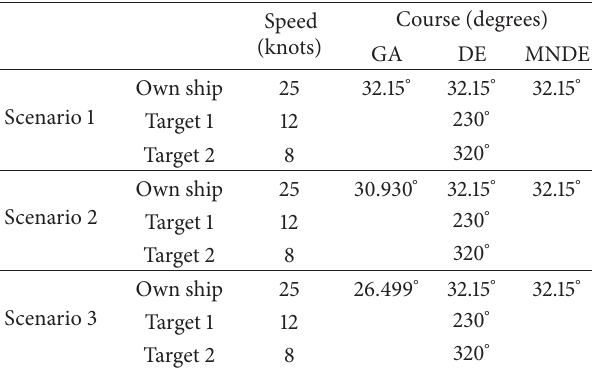
Table 5: Courses and speed configurations of the own and target ships.